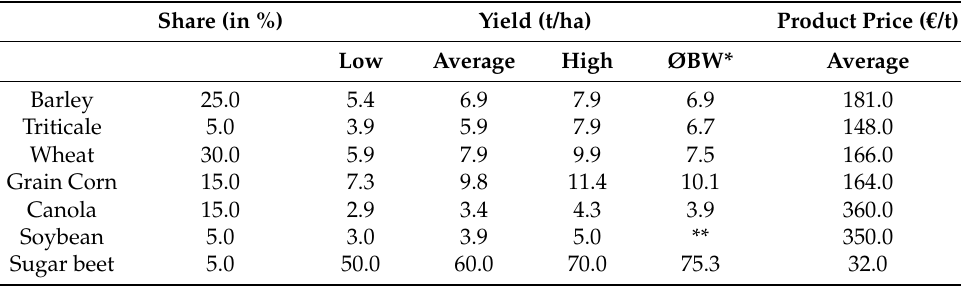
Table A3. Shares of arable crops, product prices and yield levels derived from agricultural statistics [36]. Share (in %) Yield (t/ha)